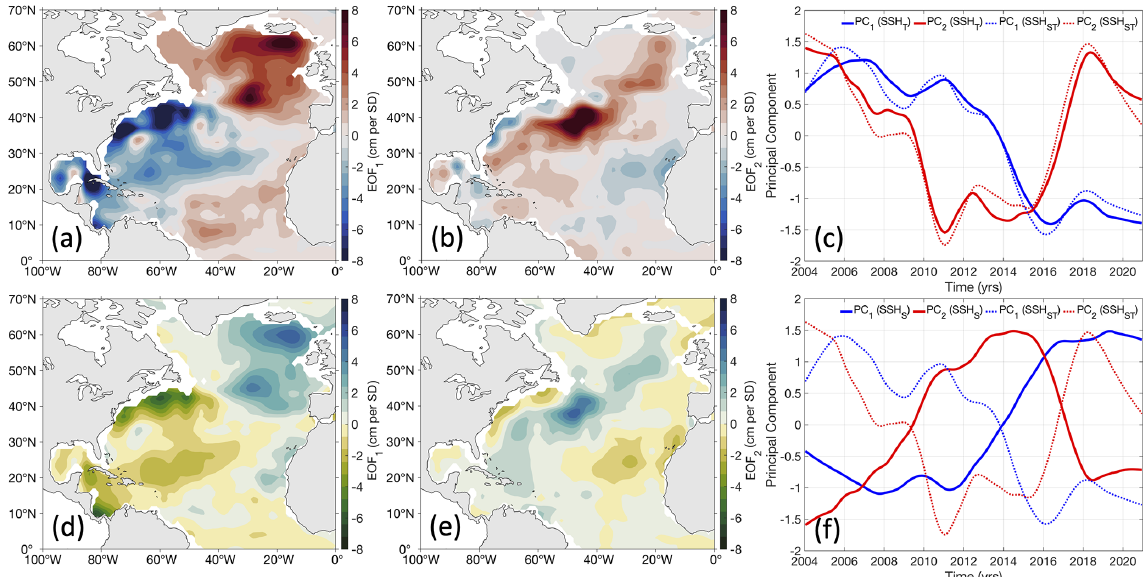
Figure 4. EOF analysis of thermosteric (SSH T ) and halosteric (SSH S ) sea level derived from EN4 temperature and salinity profiles: (a) EOF 1 and (b) EOF 2 modes of SSH T , (c) PC 1 (blue) and PC 2 (red) of SSH ST (dotted) and SSH T (solid), (d) EOF 1 and (e) EOF 2 modes of SSH S , (f) PC 1 (blue) and PC 2 (red) of SSH ST (dotted) and SSH S